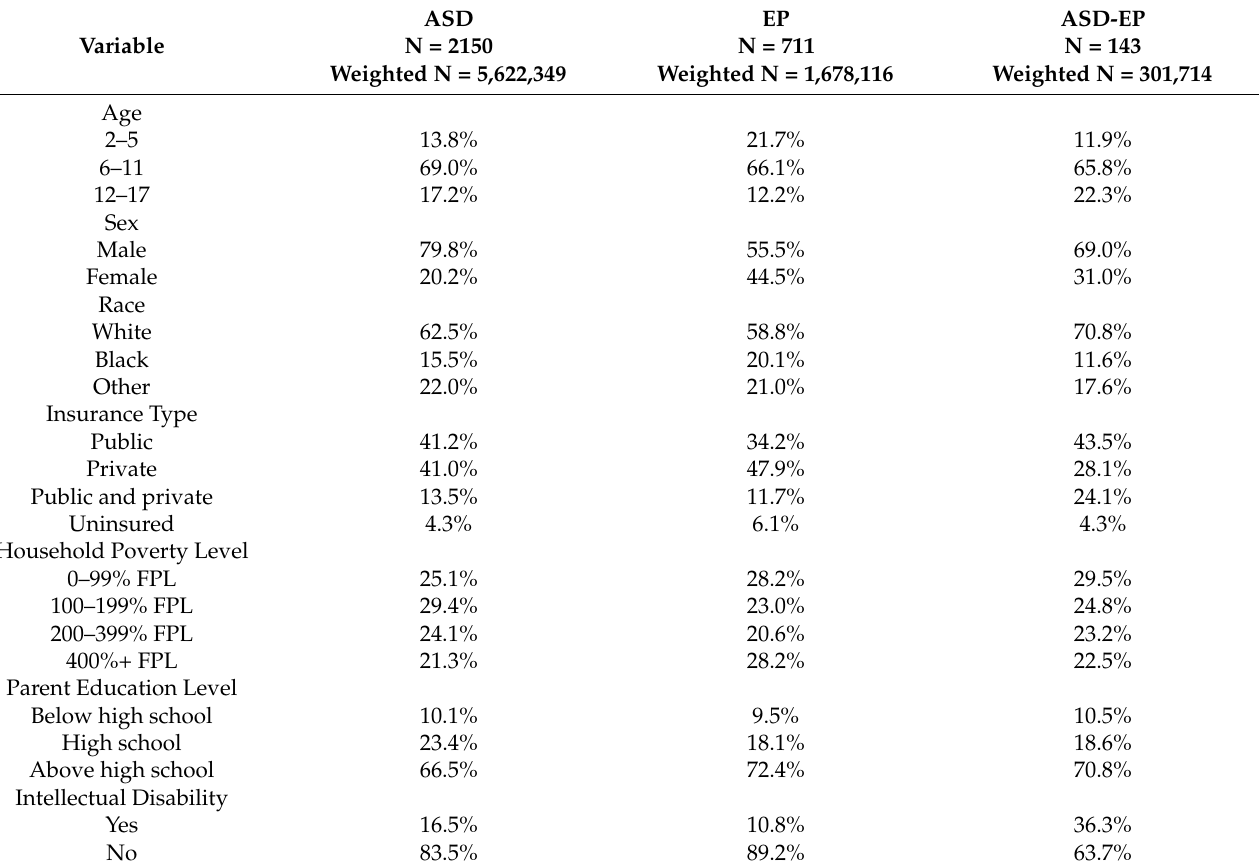
Table 1. Family and child